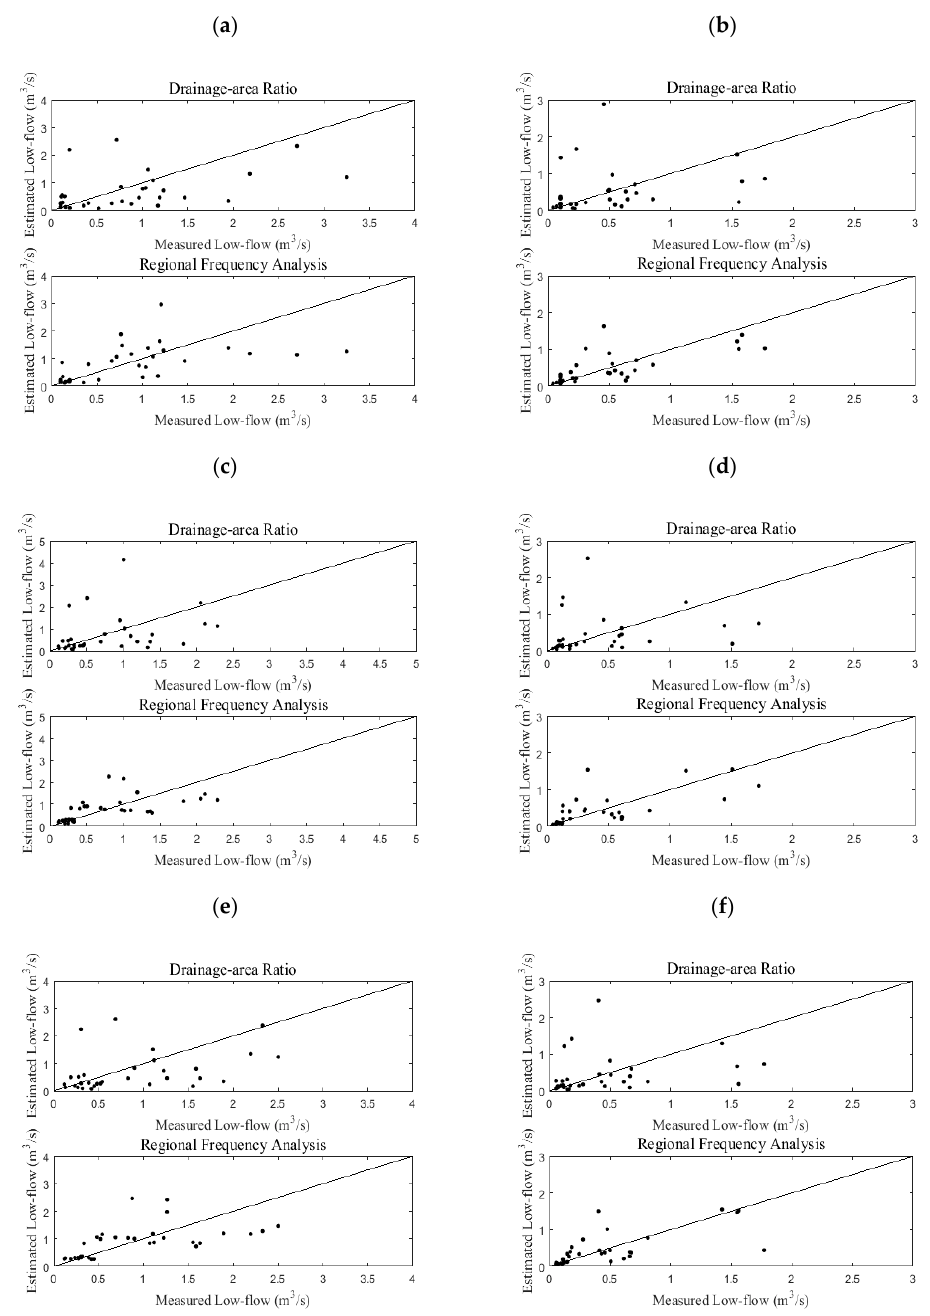
Figure 8. Plot of the estimated flow and measured flow based on the drainage-area ratio and regional frequency analysis for the ( a ) two-year quantile and ( b ) five-year quantile derived from the generalized extreme value (GEV) distribution, ( c ) two-year quantile and ( d ) five-year quantile derived from the LN2 distribution and ( e ) two-year quantile and ( f ) five-year quantile derived from the W2 distribution.